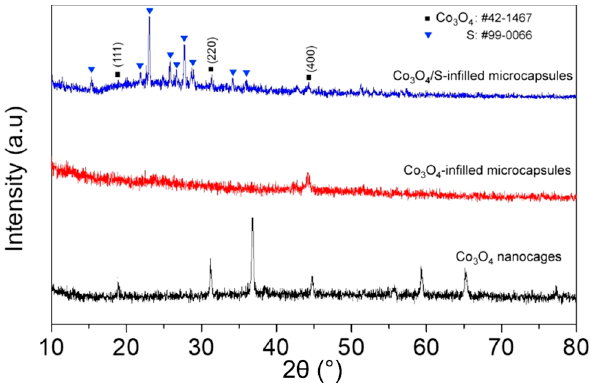
Figure 3. XRD patterns of the pristine Co 3 O 4 nanocages and the capsules infilled with Co 3 O 4 or Co 3 O 4 /S composite.